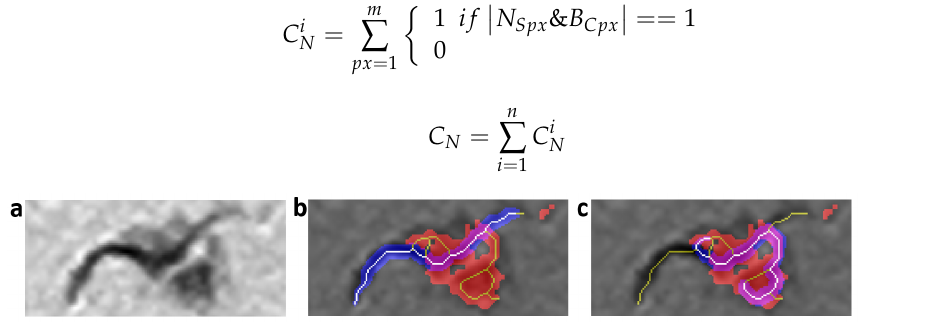
Figure 8. Noise criterion evaluation. The pixels in magenta (intersection of blue and red) are the noise error. The yellow and white pixels are the resulting skeleton using the improved form of skeletonizing. The white pixels are the pixels of the skeleton prediction, which are used to reconstruct the worm’s body (segmentation in blue). ( a ) Grayscale image. ( b ) Correct prediction with low noise criterion. ( c ) Incorrect prediction with high noise